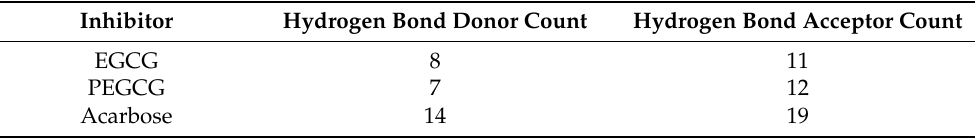
Table 7. Hydrogen bond donor and acceptor count of the